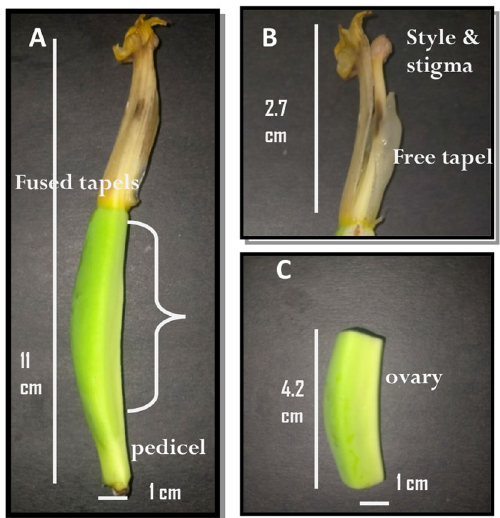
Figure 8. Image of banana female florets. ( A ) Full view of female florets, ( B ) style and stigma region of female florets, ( C ) ovary region of the female florets taken for RNA